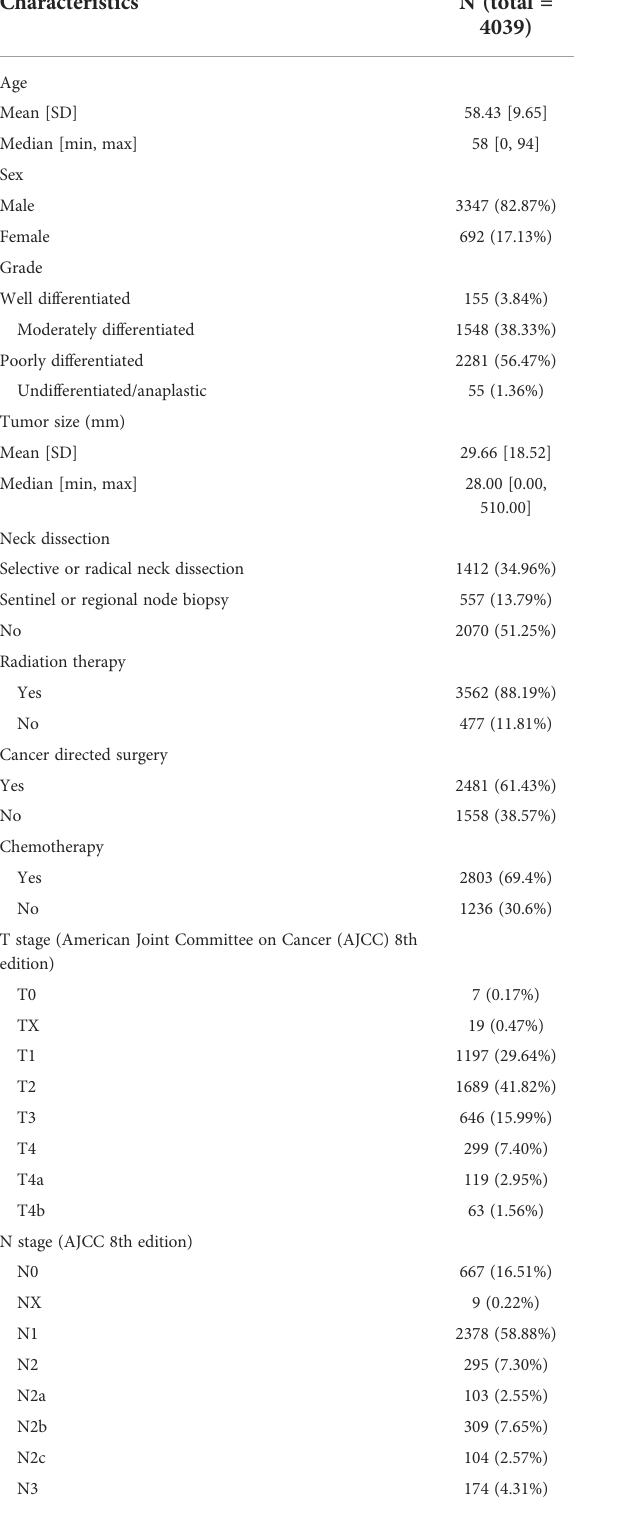
TABLE 1 Clinical and pathological characteristics of patients with oropharyngeal squamous cell carcinoma (OPSCC).